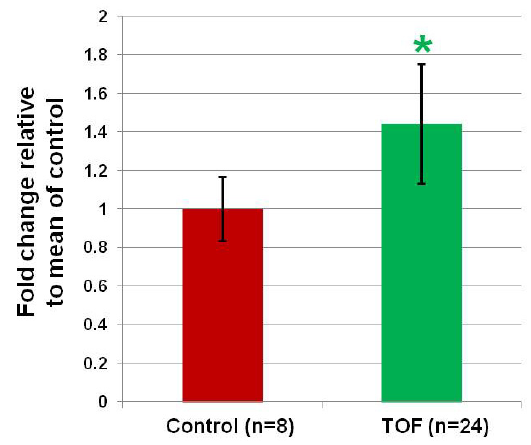
Figure 2. MiR-421 is more highly expressed in RV from infants with TOF compared to the RV from normally developing infants. Data is from qRT-PCR. * significant difference ( p = 0.03).